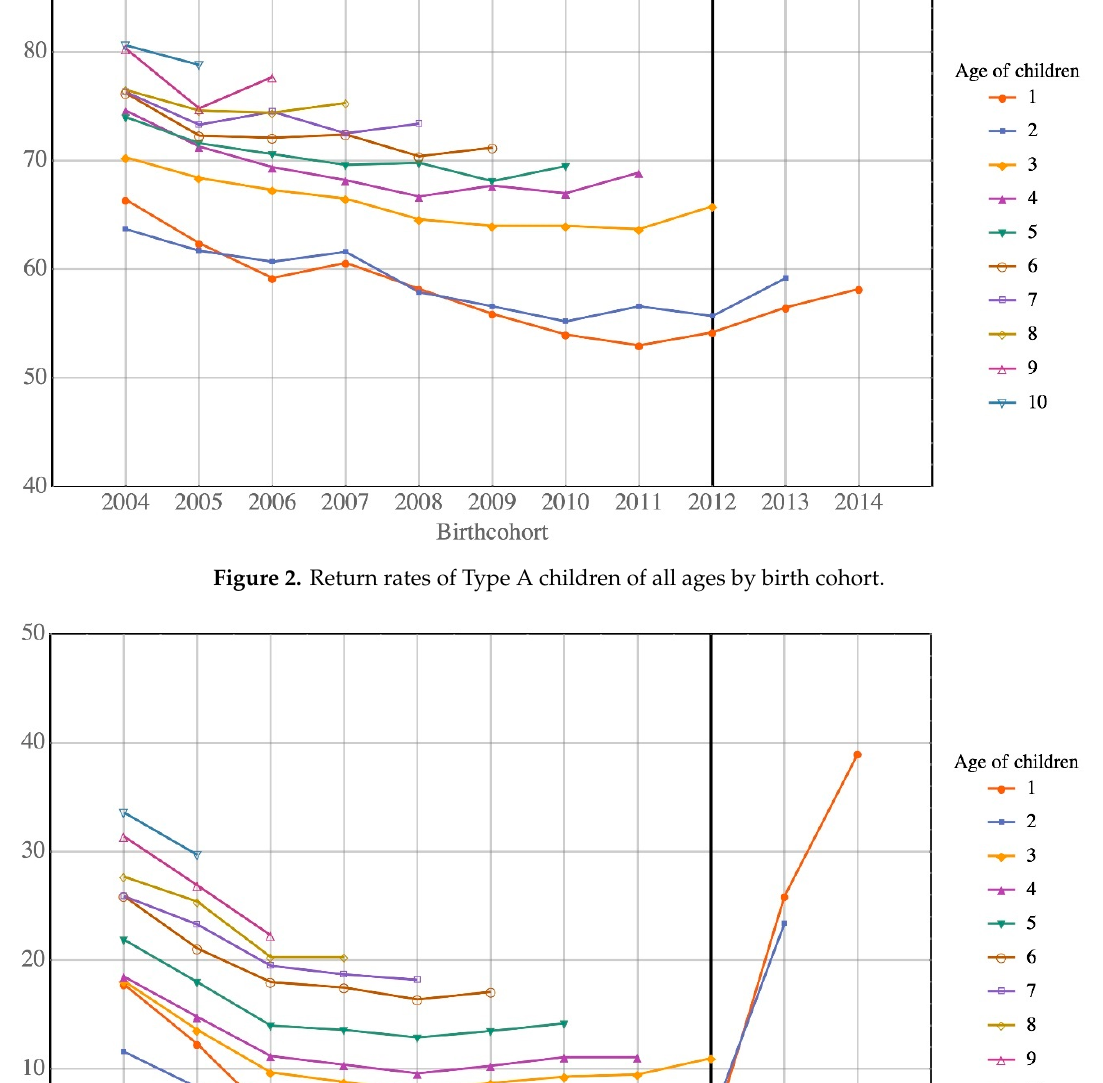
Table 3. Return rates by mothers’ education level per birth cohort in 2016.